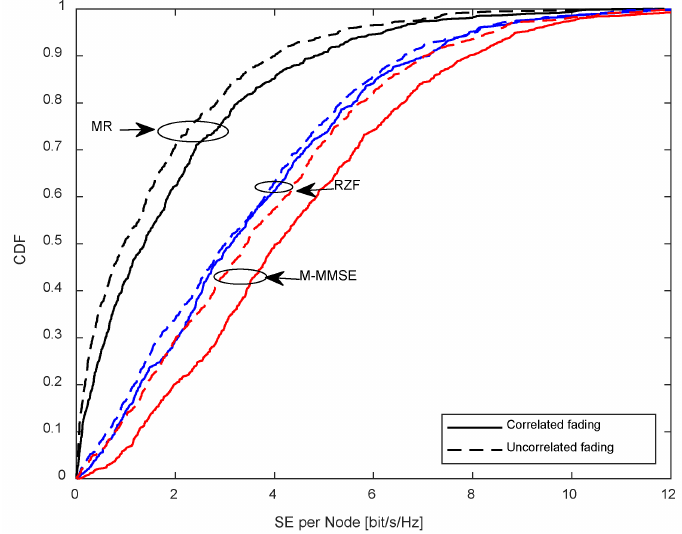
Figure 8. CDF of different schemes. A fading channel h ∈ C M is spatially uncorrelated if the channel gain (cid:107) h (cid:107) 2 and the channel direction h / (cid:107) h (cid:107) are independent random variables, and the channel direction is uniformly distributed over the unit-sphere in C M . The channel is otherwise spatially correlated